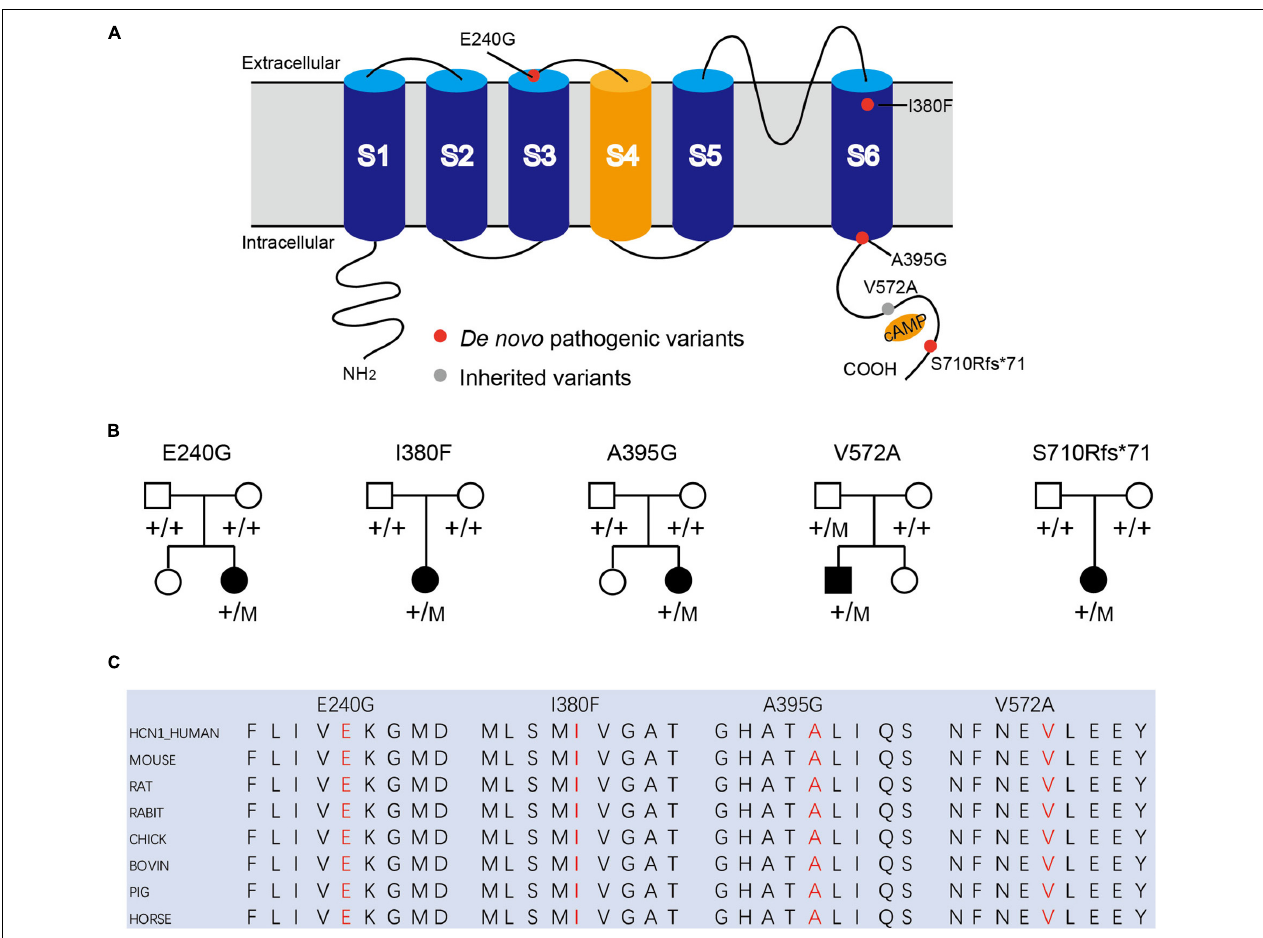
FIGURE 1 | Mutations in HCN1 channels. (A) Structure of HCN1 channels with S1-S6 segments and N/C-terminal region. (B) Pedigrees of patients with HCN1 variants. (C) All variants are highly conserved among different